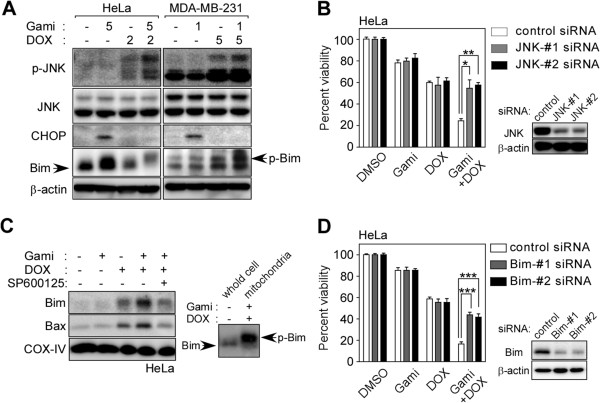
Enhancement of JNK-mediated Bim phosphorylation by drug combination treatment. (A) Phosphorylation of JNK and Bim. HeLa and MDA-MB-231 cells were treated with DOX and gamitrinib alone or in combination for 24 hours as indicated and analyzed by western blotting. (B) JNK silencing compromises the synergistic effect of combination treatment. HeLa cells were treated with JNK siRNA prior to treatment with 2 μM DOX and 5 μM gamitrinib as indicated for 24 hours. Cell viability was analyzed by MTT assay. Data are mean ± SEM of two independent experiments performed in triplicate. *, p < 0.02; **, p = 0.0004. (C) Mitochondrial accumulation of Bim and Bax. After treatment of HeLa cells with 5 μM gamitrinib, 2 μM DOX, or 10 μM SP600125 as indicated, mitochondria were fractionated and analyzed by western blotting (left). Bim phosphorylation in the whole cell extract and the mitochondrial fraction (right). (D) Effect of Bim silencing. After treatment with control or Bim-specific siRNAs, HeLa cells were incubated with 2 μM DOX and 5 μM gamitrinib for 24 hours as indicated and analyzed by MTT assay. Data show mean ± SEM of two independent experiments performed in triplicate. ***, p < 0.0001.